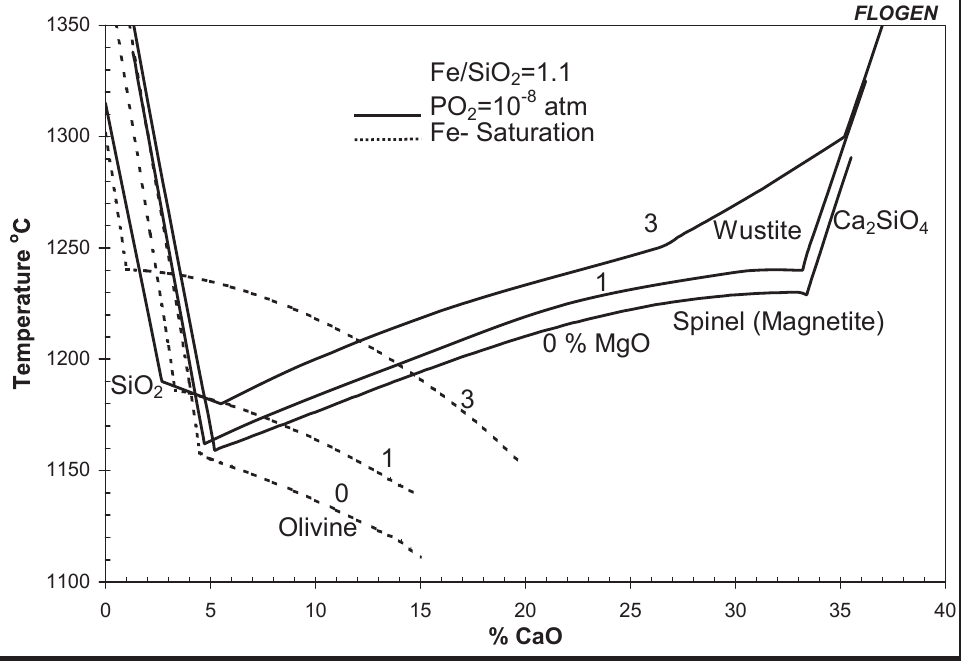
Figure 9. Effect of MgO on the liquidus temperature of CaO-FeO-Fe 2 O 3 -SiO 2 -Mg 2 O slag at Fe = SiO 2 D 1:1 and vari- ous oxygen